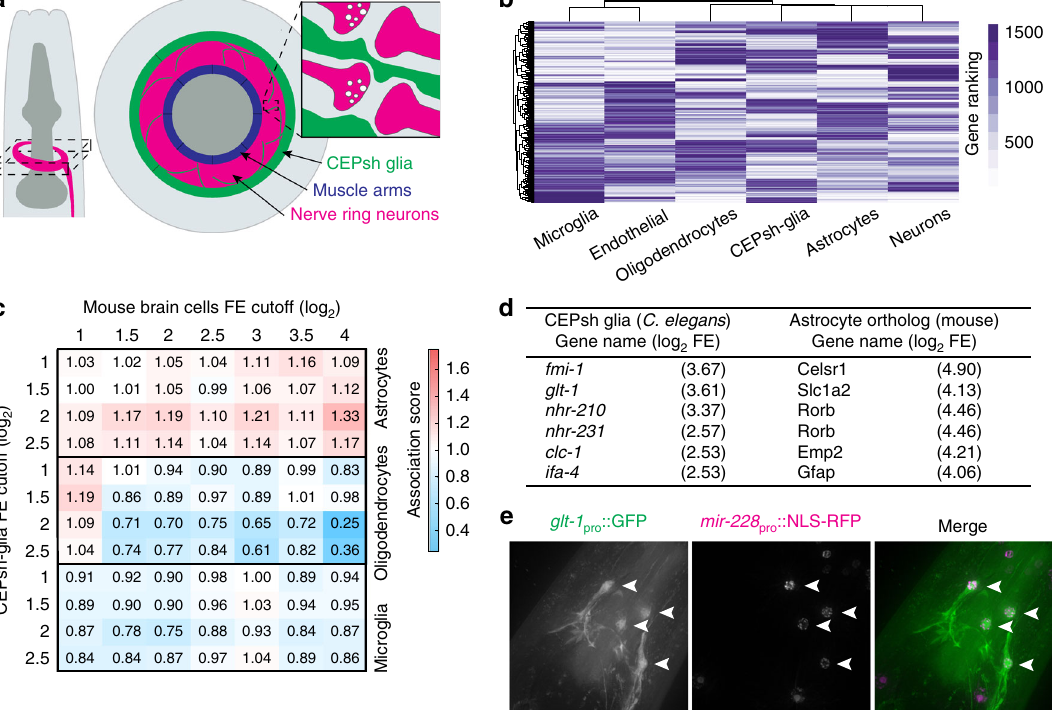
Fig. 1 CEPsh glia share molecular similarities with astrocytes, including GLT-1 expression. a Schematic of C. elegans head (left), anterior is up, ventral is right. Cross-section of dashed area is enlarged (middle). Magenta, nerve ring; green, CEPsh glia; blue, muscle arms. Interactions of CEPsh glia processes with synapses are illustrated (inset). b Hierarchical clustering of mouse brain cells and CEPsh glia-expressed genes. x -axis dendrogram indicates the relationships among different cell types, y -axis dendrogram indicates relationships across individual genes. c Overrepresentation comparison of CEPsh glia- enriched genes with gene orthologs enriched in mouse glial cells. Normalized association values indicated by numbers and heatmap (FE, fold-enrichment). d Examples of CEPsh glia-enriched genes with orthologous genes enriched in mouse astrocytes. e Maximum intensity projections of deconvolved optical sections. glt-1 promoter expression in CEPsh glia (left; arrowheads), mir-228 glial promoter expression (middle; CEPsh glia, arrowheads); merged image (right). Scale bar, 8 μ